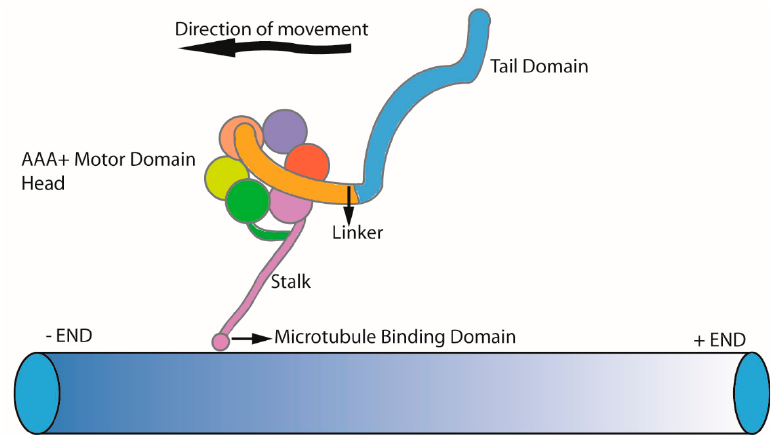
Figure 2. Simplified structure of the dynein heavy chain, containing a heavy chain head with an AAA+ motor domain, a stalk with a microtubule binding domain, a linker, and a variable tail domain where other dynein subunits bind.